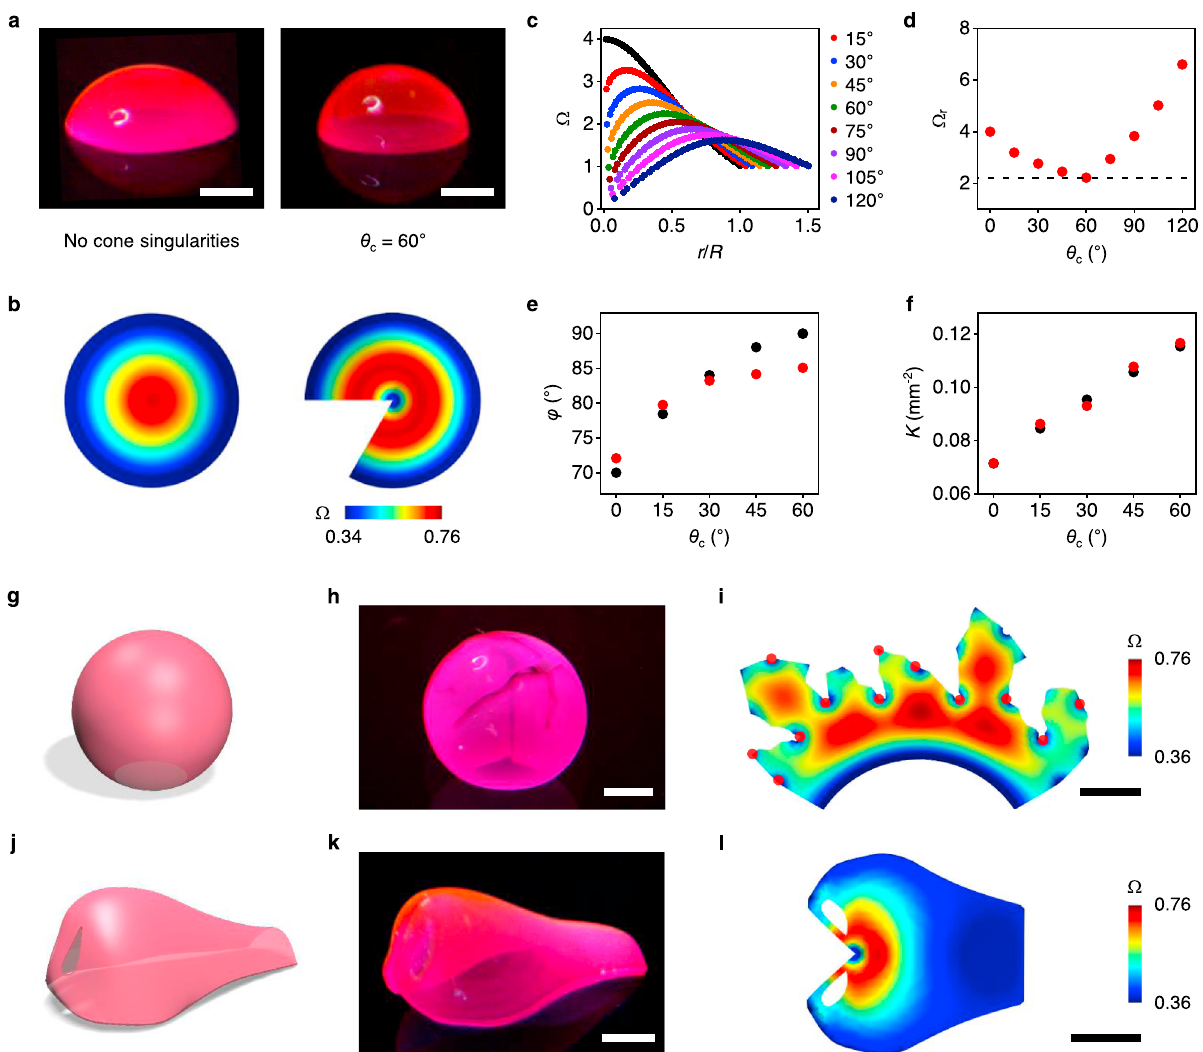
Fig. 3 Cone singularities. a Hemispheres formed without cone singularities (left) and with a cone singularity with cone angle θ c = 60° (right). b 2D growth Ω (left) and Ω with a cone singularity with θ = 60° (right) used to print the hemispheres in a . c Ω computed for a hemisphere using a cone singularity with c different θ c as a function of normalized radial position r / R . d Ω r required to form a full hemisphere with different θ c . Ω r = Ω max / Ω min , where Ω max and Ω min are the maximum and minimum values of Ω , respectively. The dashed line indicates Ω r = 2.22. e Experimentally measured (red circles) and computationally calculated (black circles) cap angle φ as a function of θ c . φ is the polar angle from the pole of the cap to its base in a spherical coordinate system. f Experimentally measured (red circles) and computationally calculated (black circles) Gaussian curvature K as a function of θ c . g – i Printing of an almost-complete sphere with 12 cone singularities: target shape ( g ), experimentally printed structure ( h ), and Ω with cone singularities (red circles)